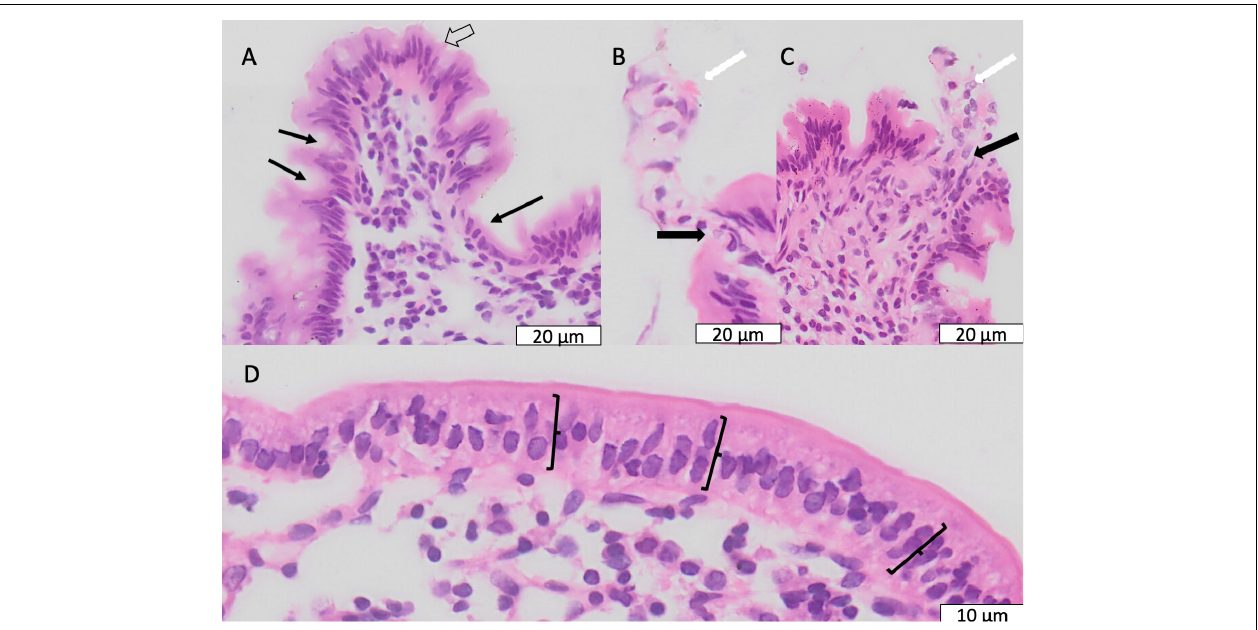
FIGURE 4 | Enterocyte morphological abnormalities. (A) Variable epithelial height, ranging from full epithelial height to severe flattening (black arrows); at the villus tip there is also scalloping (white hollow arrow) which frequently resembled tufting. (B,C) Villus tip epithelial defect (solid black arrow) allowing extrusion of lamina propria contents (white arrows) into lumen. (D) Pseudostratification, the misalignment of nuclei into layers (range illustrated by brackets) which normally occupy a uniformly basal position in the enterocyte.